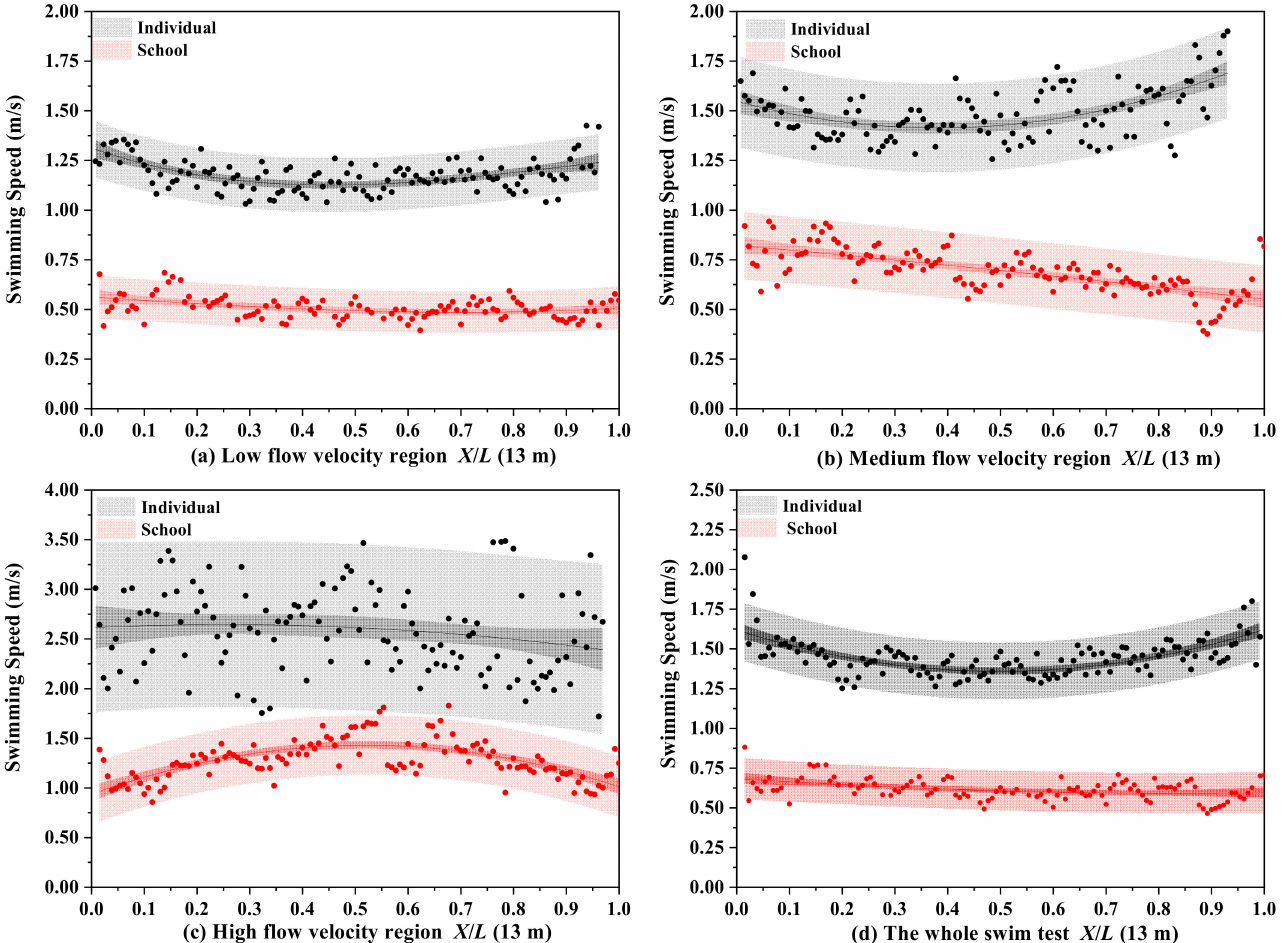
Figure 3. Swimming speeds with 95% confidence intervals (quantified by internal estimation) for individual S. prenanti and schooling in different flow velocity regions (low ( a ), medium ( b ), high ( c ) and the whole swim test area ( d )). x is the position of the fish along the flow direction, and L (13 m) is the length of the swim test area in the open-channel